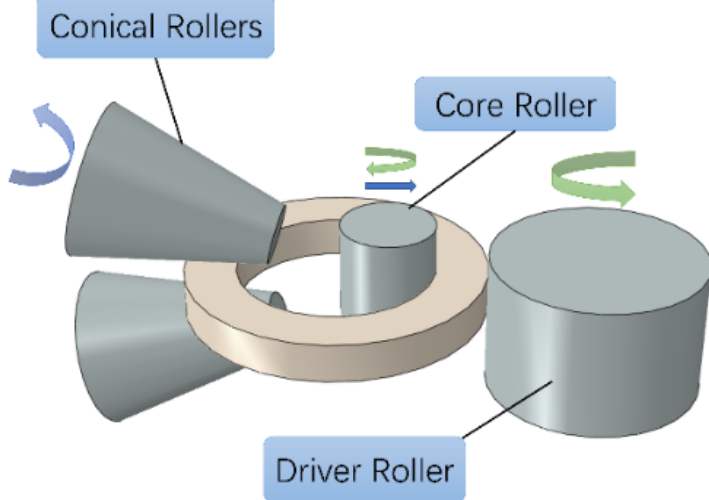
Figure 1. Rolling ring model.